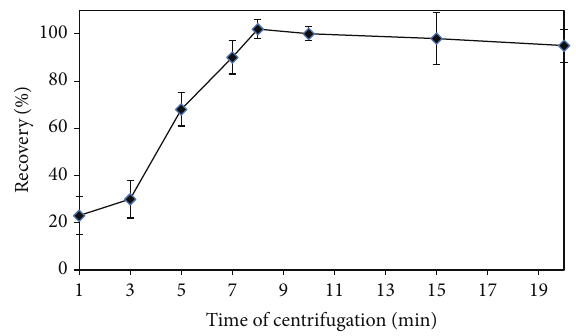
Figure 6: Effect of the centrifugation time on the extraction efficiency of the DLLME extraction procedure for Bi(III) ions. Table 1: Effect of foreign ions on the determination